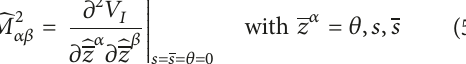
Fields Eigenstates